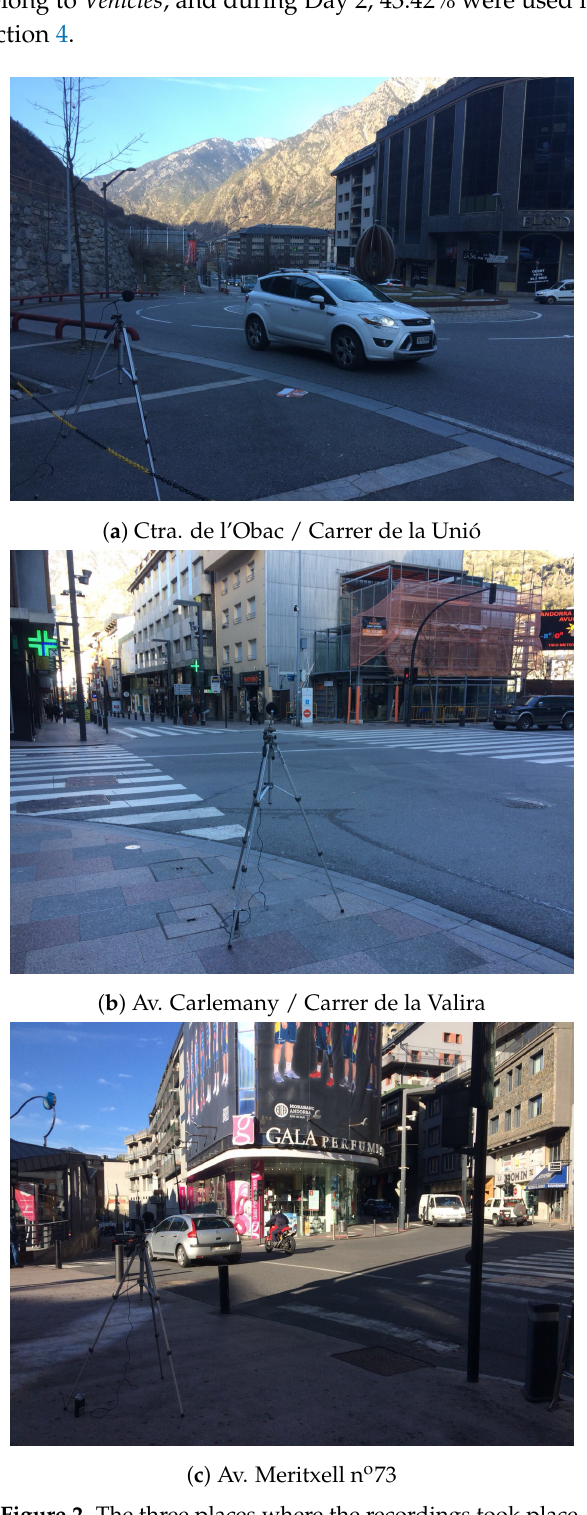
Figure 2. The three places where the recordings took